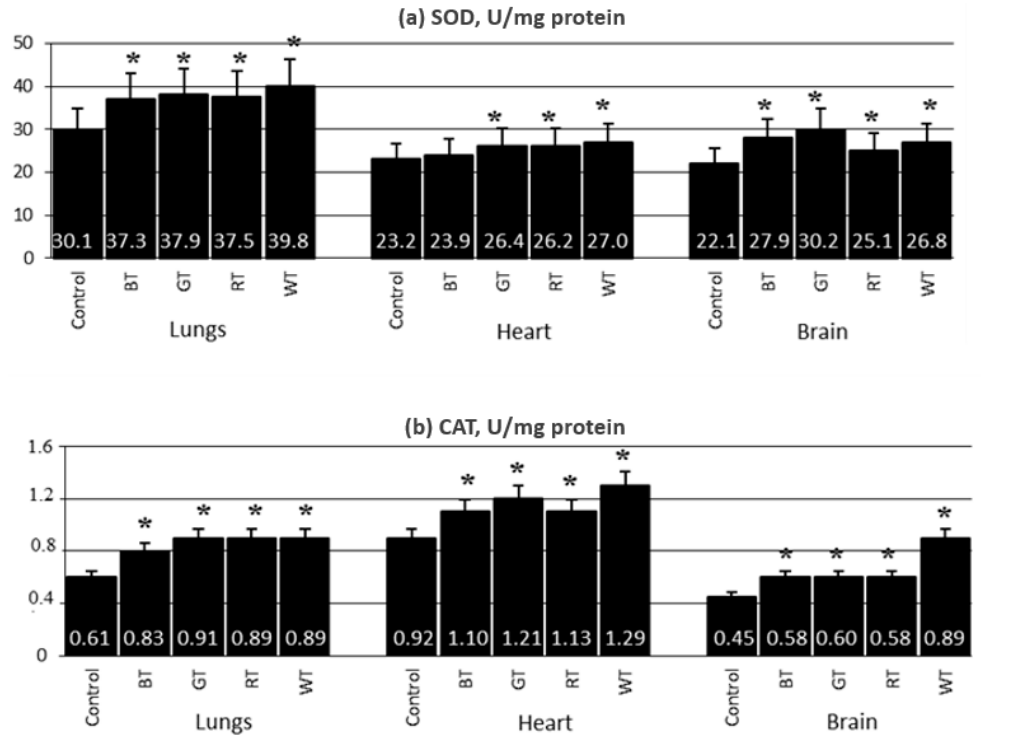
Figure 5. Experiment 2—Mean values of SOD and CAT activity in the lungs, heart and brain for 12 weeks of exposure (mean ± SD). SD—standard deviation; * significant versus 0% TA ( p < 0.05), BT—black tea treated group, GT—green tea treated group; RT—red tea treated group; WT—white tea treated group.